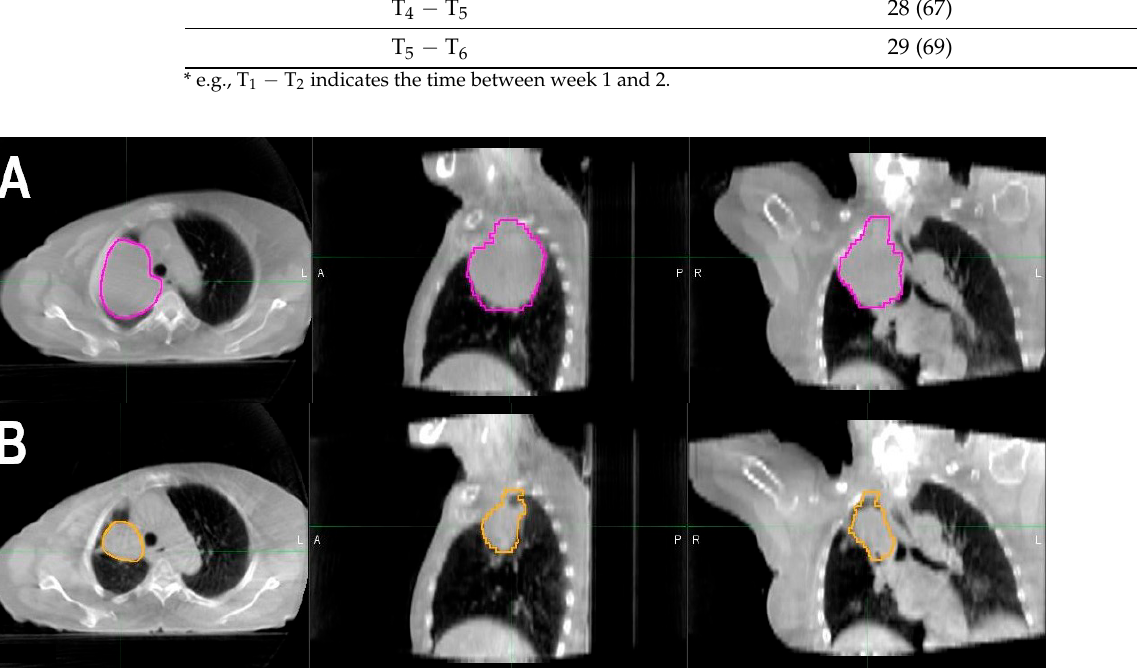
Log ‐ rank, p = 0.39